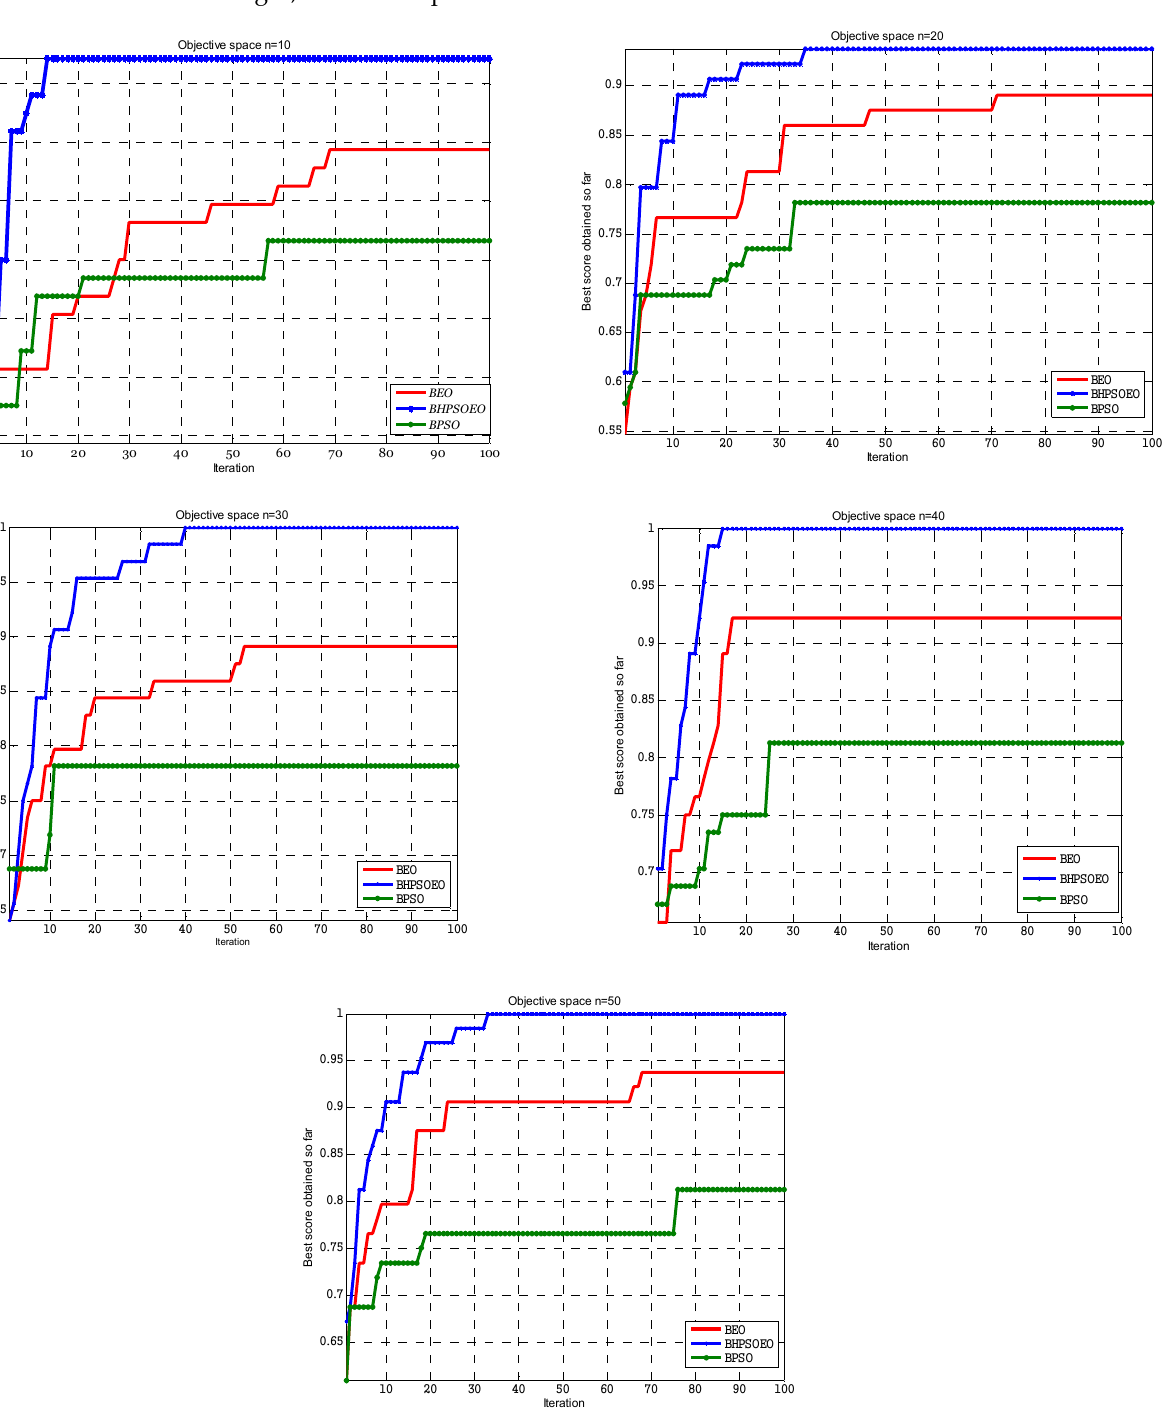
Figure 7. Convergence curve of BHPSOEO, BPSO and BEO for cryptanalysis of RC4 cipher with TextLen = 64 bits for different population sizes.